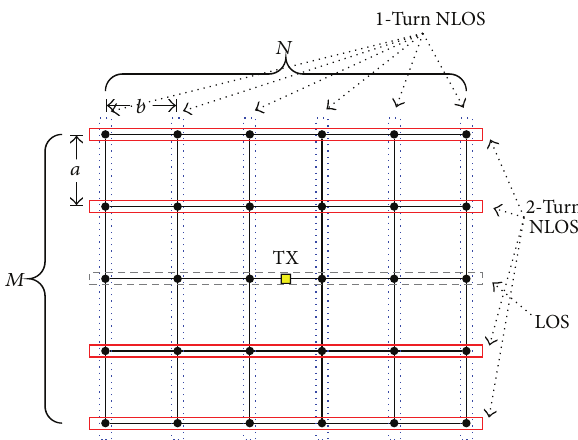
Figure 7: LOS, 1-Turn NLOS, and 2-Turn NLOS situationsin an 𝑀× 𝑁 rectangular street grid: black dots and edges denote corners and streets in the street